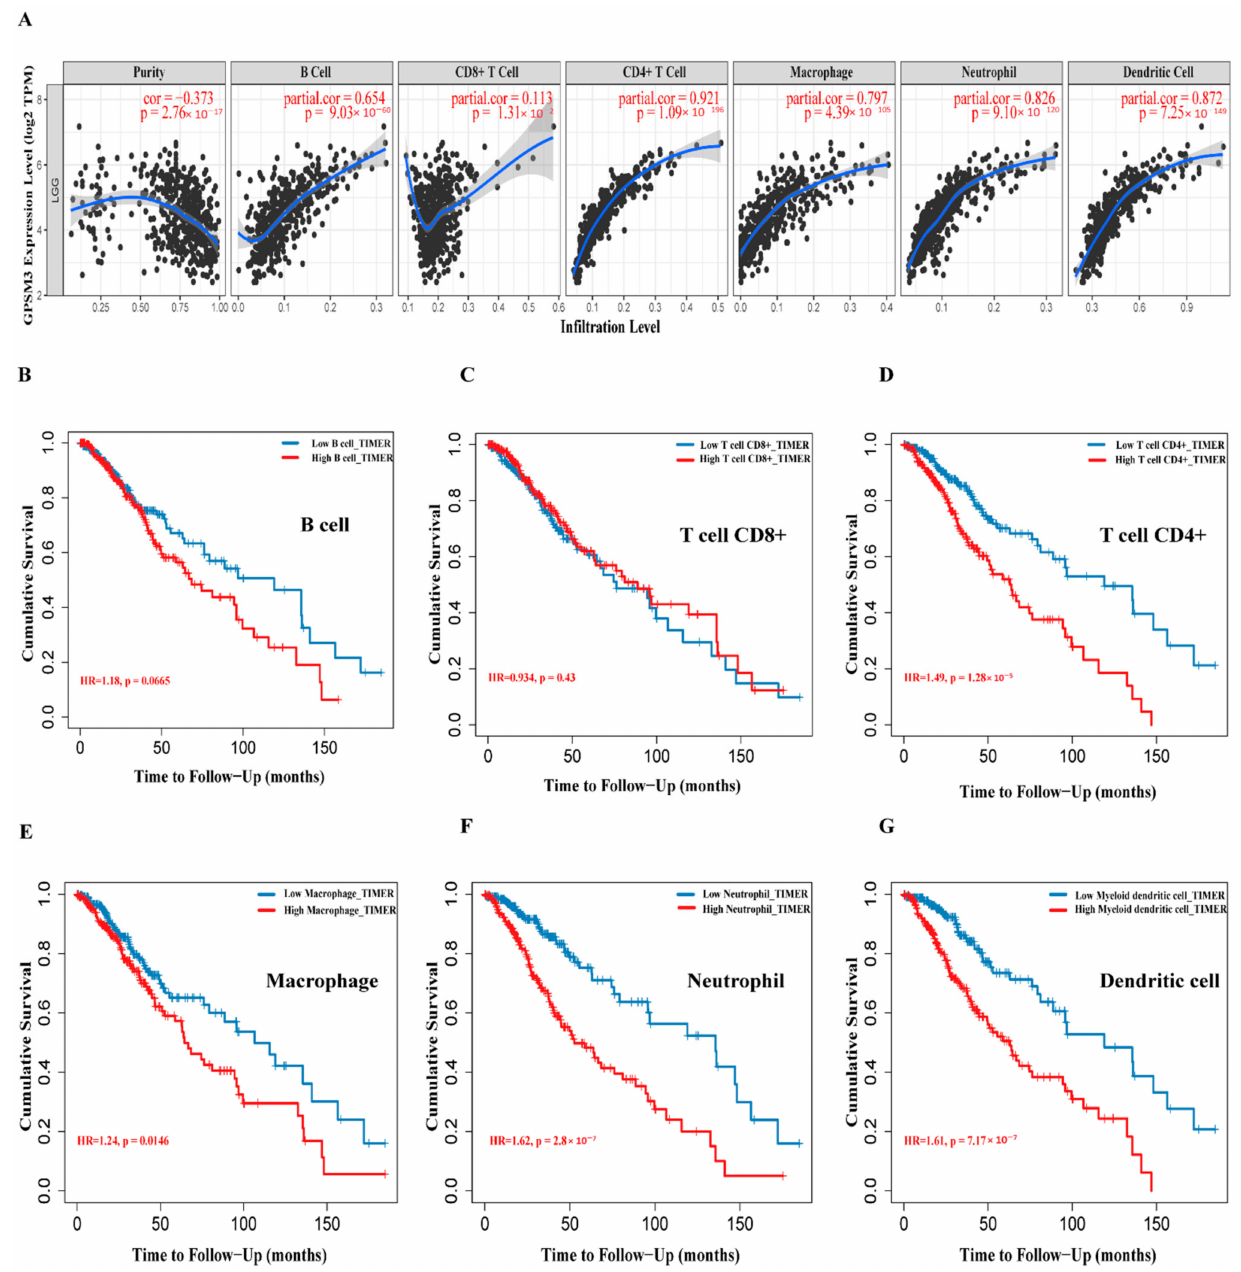
Figure 6. Correlation between GPSM3 expression and immune cell infiltration. ( A ) The correlation between the GPSM3 expression level and infiltrating levels of B cell (r = − 0.654, p = 9.03 × 10 − 6 ), CD8+ T cells (r = − 0.113, p = 1.31 × 10 − 2 ), CD4+ T cells (r = − 0.921, p = 1.09 × 10 − 196 ), Macrophages (r = − 0.797, p = 4.39 × 10 − 105 ), Neutrophils (r = − 0.862, p = 9.10 × 10 − 120 ), and DCs (r = − 0.872, p = 7.25 × 10 − 149 ) in LGG. ( B – G ) Cumulative survival analysis related to the infiltration of B cell, T cells, Macrophages, Neutrophils and DCs in LGG. p -Value < 0.05 was considered statistically